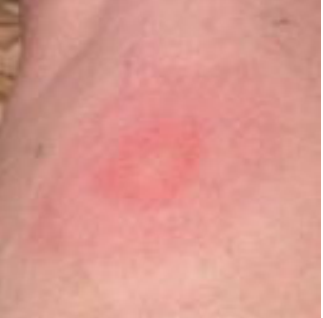
Figure 6. Erythema migrans, a ring-shaped or bull’s-eye rash on the upper leg of a middle-aged woman. This erythematous lesion is a classic erythema migrans (EM) rash.